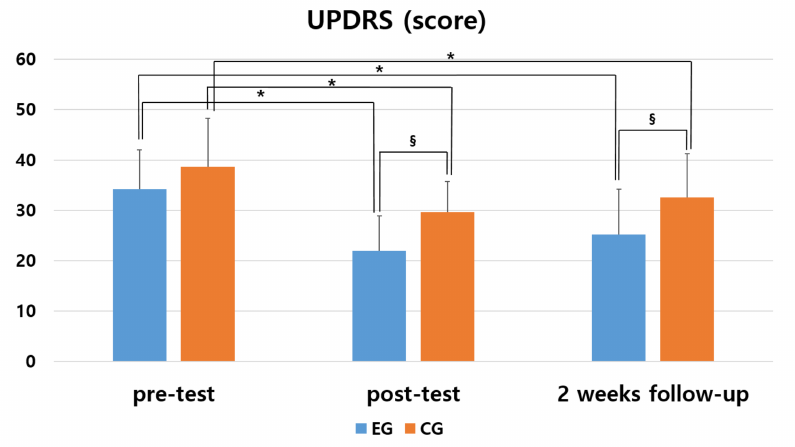
Figure 2. Comparison of the changes of within and between groups in UPDRS. * means a statistical significance within the group as compared to pre ( p < 0.05). § means a statistical significance by measurement period between groups ( p < 0.05).